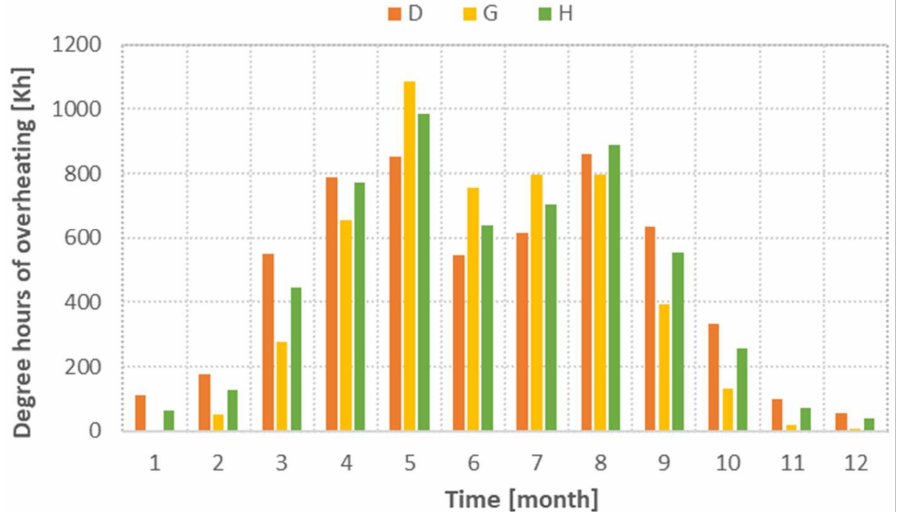
Figure 9. Degree hours of overheating of PV panels equipped with reflective